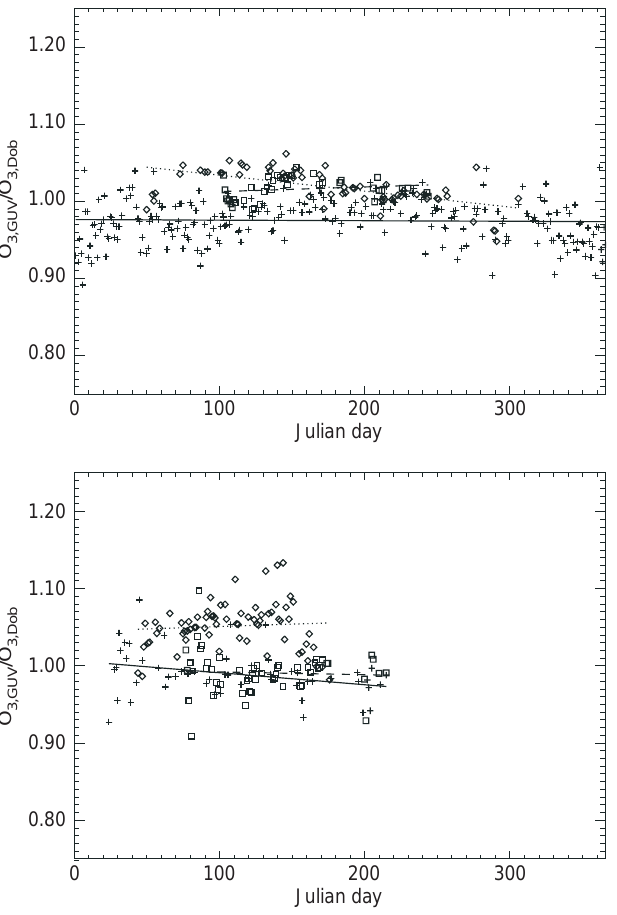
Fig. 1. Ratio between GUV and Dobson daily average total ozone data in 1996 ( upper panel ) and 1997 ( lower panel ): Oslo ( crosses ), Tromsø ( diamonds ), Ny-A˚ lesund ( squares ). Lines: linear regressions for Oslo ( solid ), Tromsø ( dotted ) and Ny-A˚ lesund ( dashed